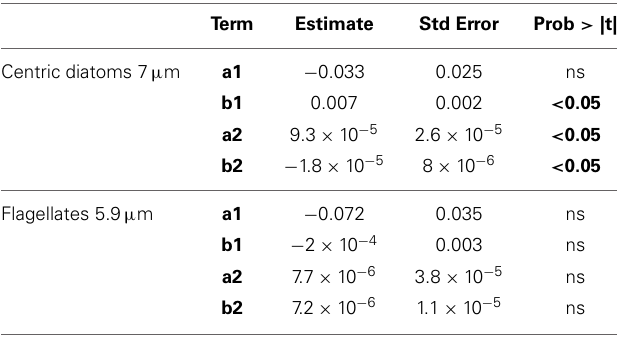
Table 3 | Statistical analysis of the effects of increased temperature and p CO 2 individually (b 1 and a 2 , respectively) and with interaction (b 2 ), on the decay rates (d − 1 ) of living